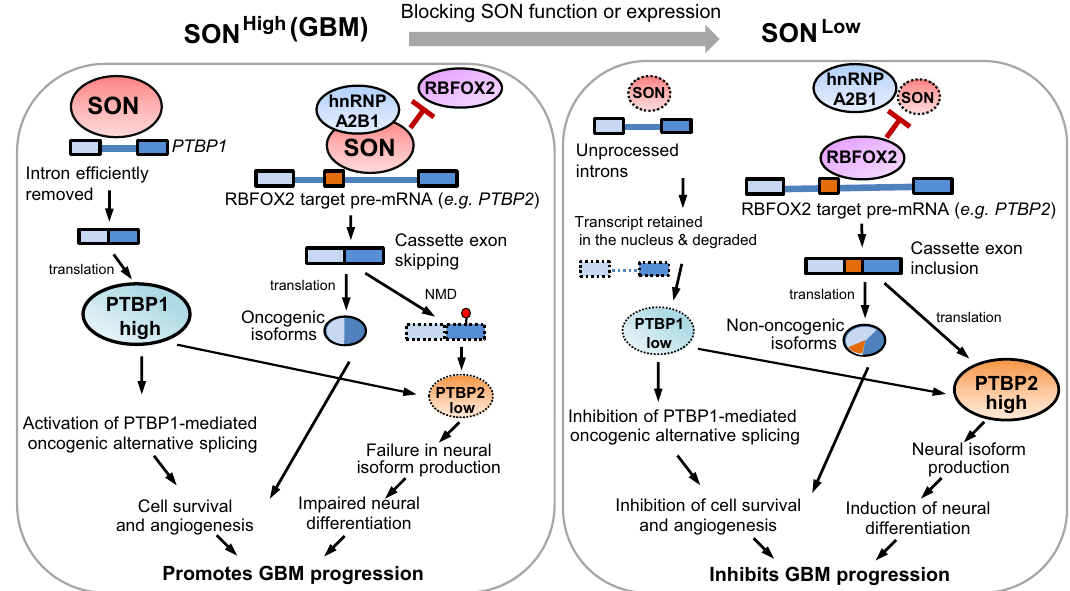
Fig. 9 Proposed molecular mechanisms of SON action in the regulation of RNA splicing in GBM. SON upregulates PTBP1 to facilitate the PTBP1-mediated oncogenic splicing program while cooperating with hnRNP A2B1 to antagonize RBFOX2 function, leading to skipping of RBFOX2-activated cassette exons, including the PTBP2 neuronal exon. Therefore, SON triggers splicing programs that promote cell survival while blocking neuronal differentiation. Inhibition of SON function or reducing SON expression would be an effective way to re-shape the splicing programs by reversing the PTBP1/PTBP2 ratio as well as restoring RBFOX2 function, which can turn off oncogenic splicing and turn on neuronal differentiation in